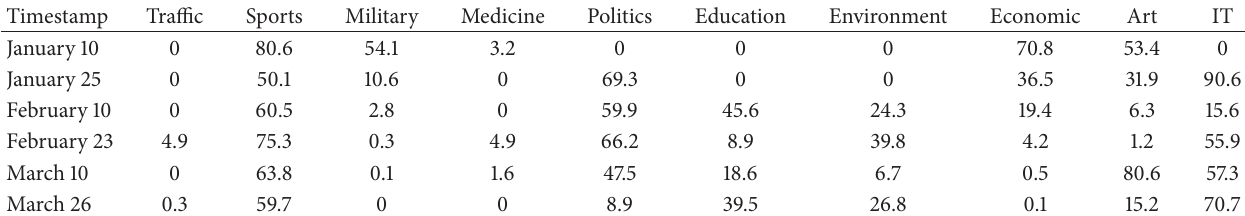
Table 1: The short-term interest model of Brooklyn.